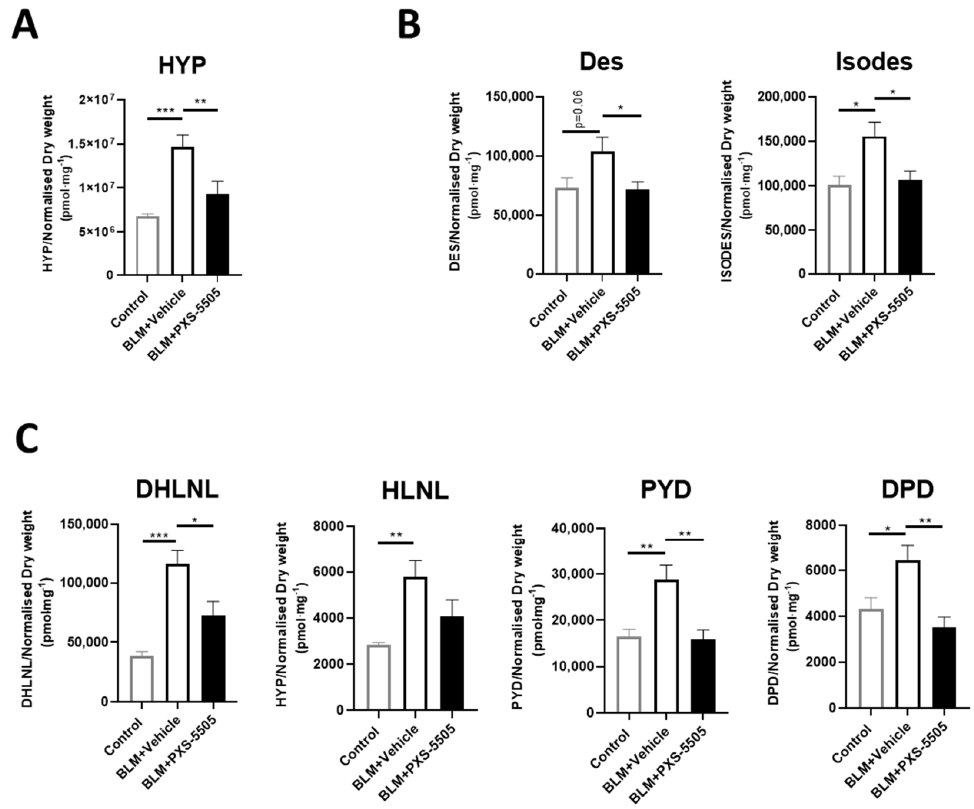
Figure 4. Effect of PXS-5505 treatment on collagen content and crosslinks of elastin and collagen in bleomycin-induced fibrotic mouse lung. Bleomycin elevated the expression of ( A ) hydroxypro- line (HYP), ( B ) elastin crosslinks [desmosine (Des) and isodesmosine (Isodes)] and ( C ) immature [dihydroxy-lysinonorleucine (DHLNL) and hydroxylysinonorleucine (HLNL)] and mature